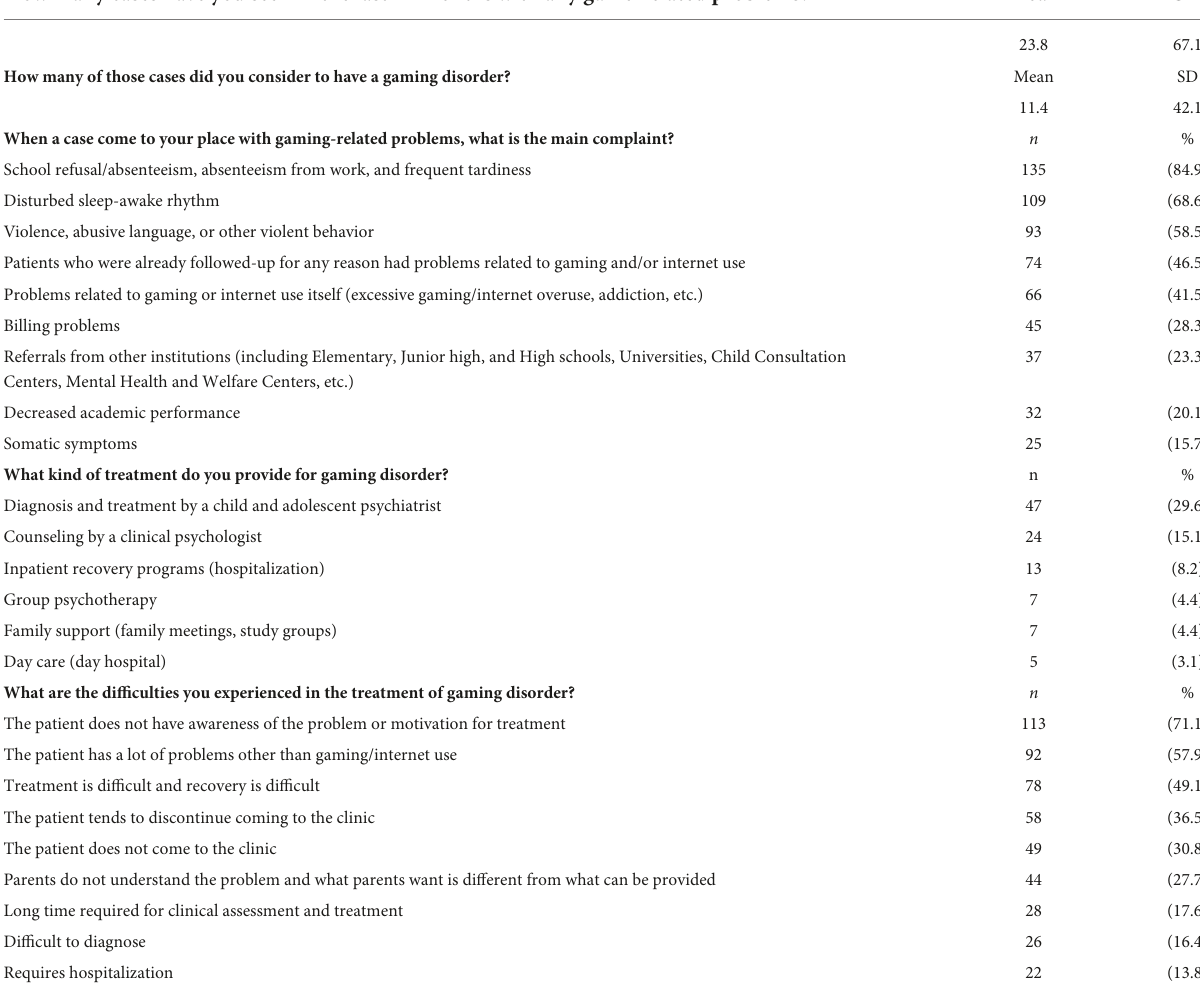
TABLE 2 Current status of clinical practice of gaming disorder ( n = 159).